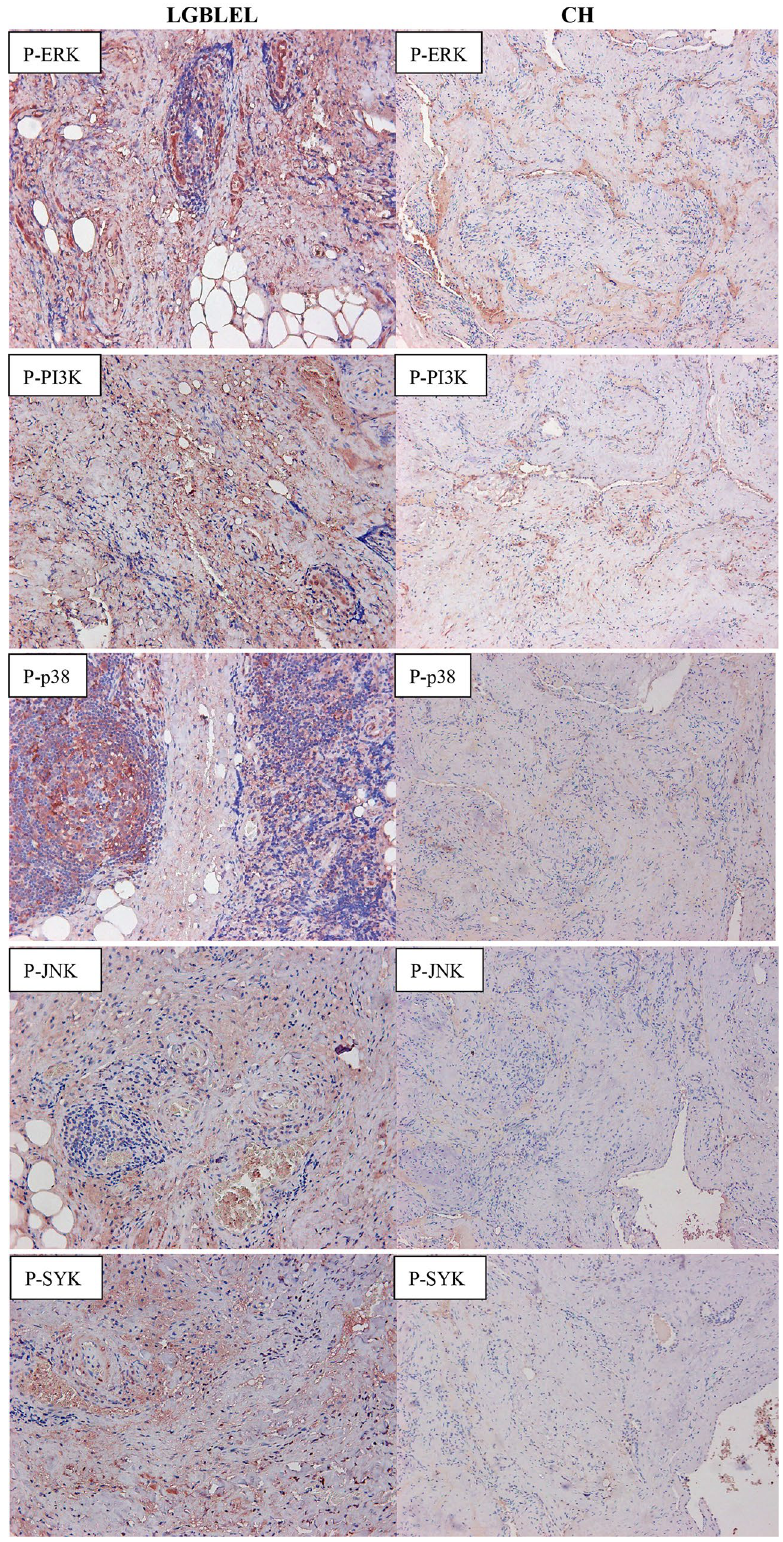
Figure 4. Immunohistochemical staining of proteins related to the FcεRI signaling pathway in LGBLEL and CH. P-Syk, P-p38, and P-ERK proteins are shown as brownish yellow in LGBLEL tissues (SP method, magnification X200), and the expression levels were higher than in orbital CH (SP method, magnification X100). P-JNK and P-PI3K were positively expressed in interstitial tissue, but not in lymphoepithelial lesions in LGBLEL (SP method, magnification